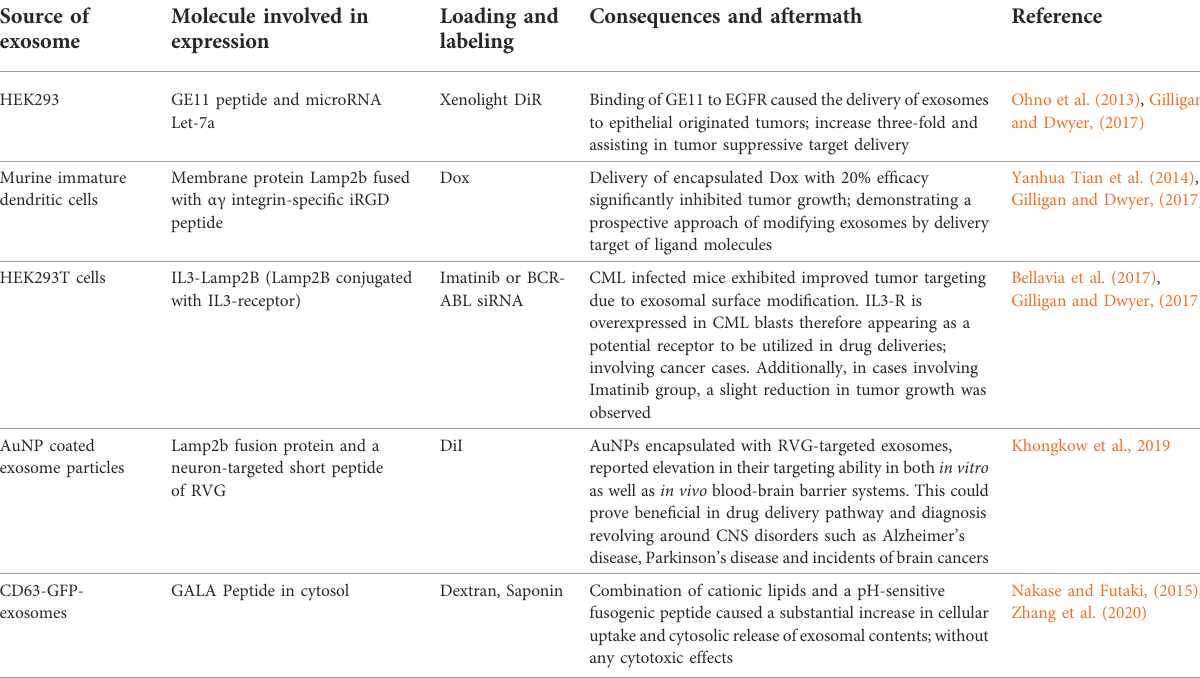
TABLE 4 A list of practical changes carried out on exosomal surfaces to assist their involvement in promoting advancements and therapies. Source of